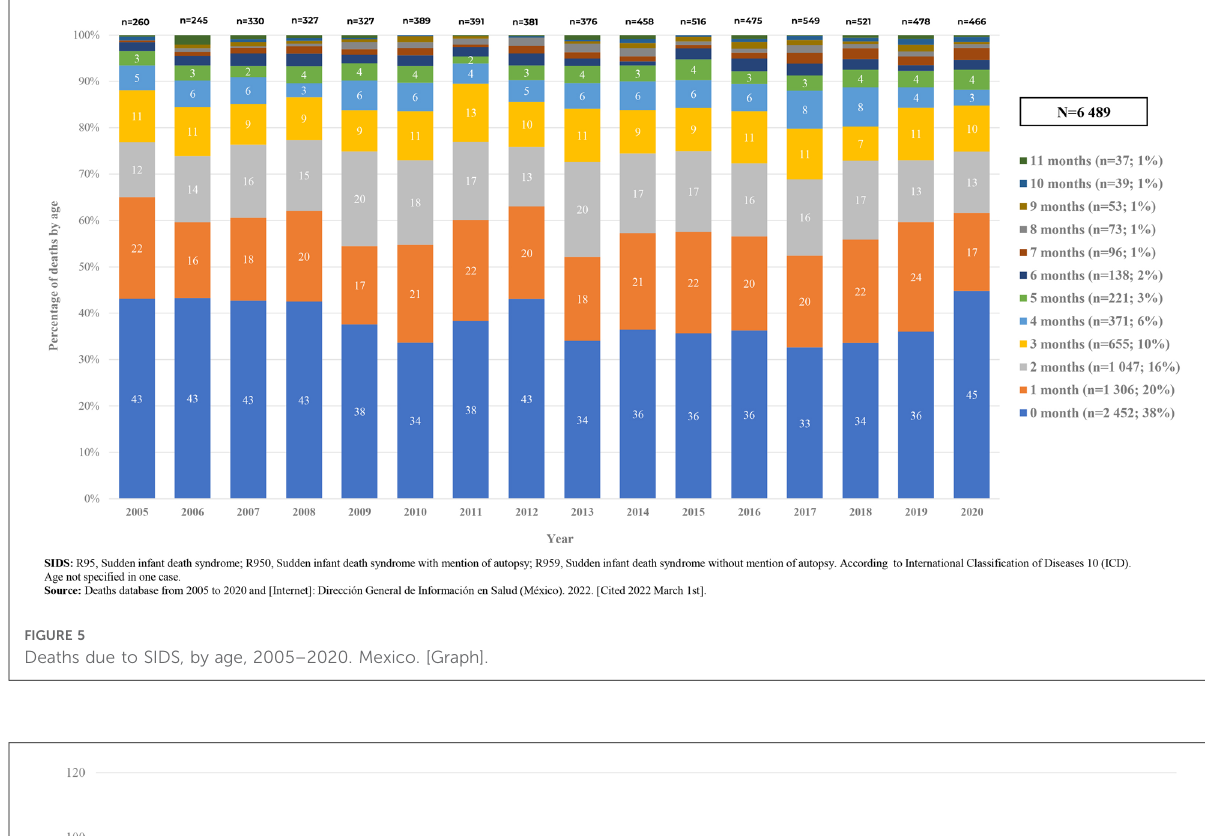
FIGURE 5 Deaths due to SIDS, by age, 2005 – 2020. Mexico. [Graph].